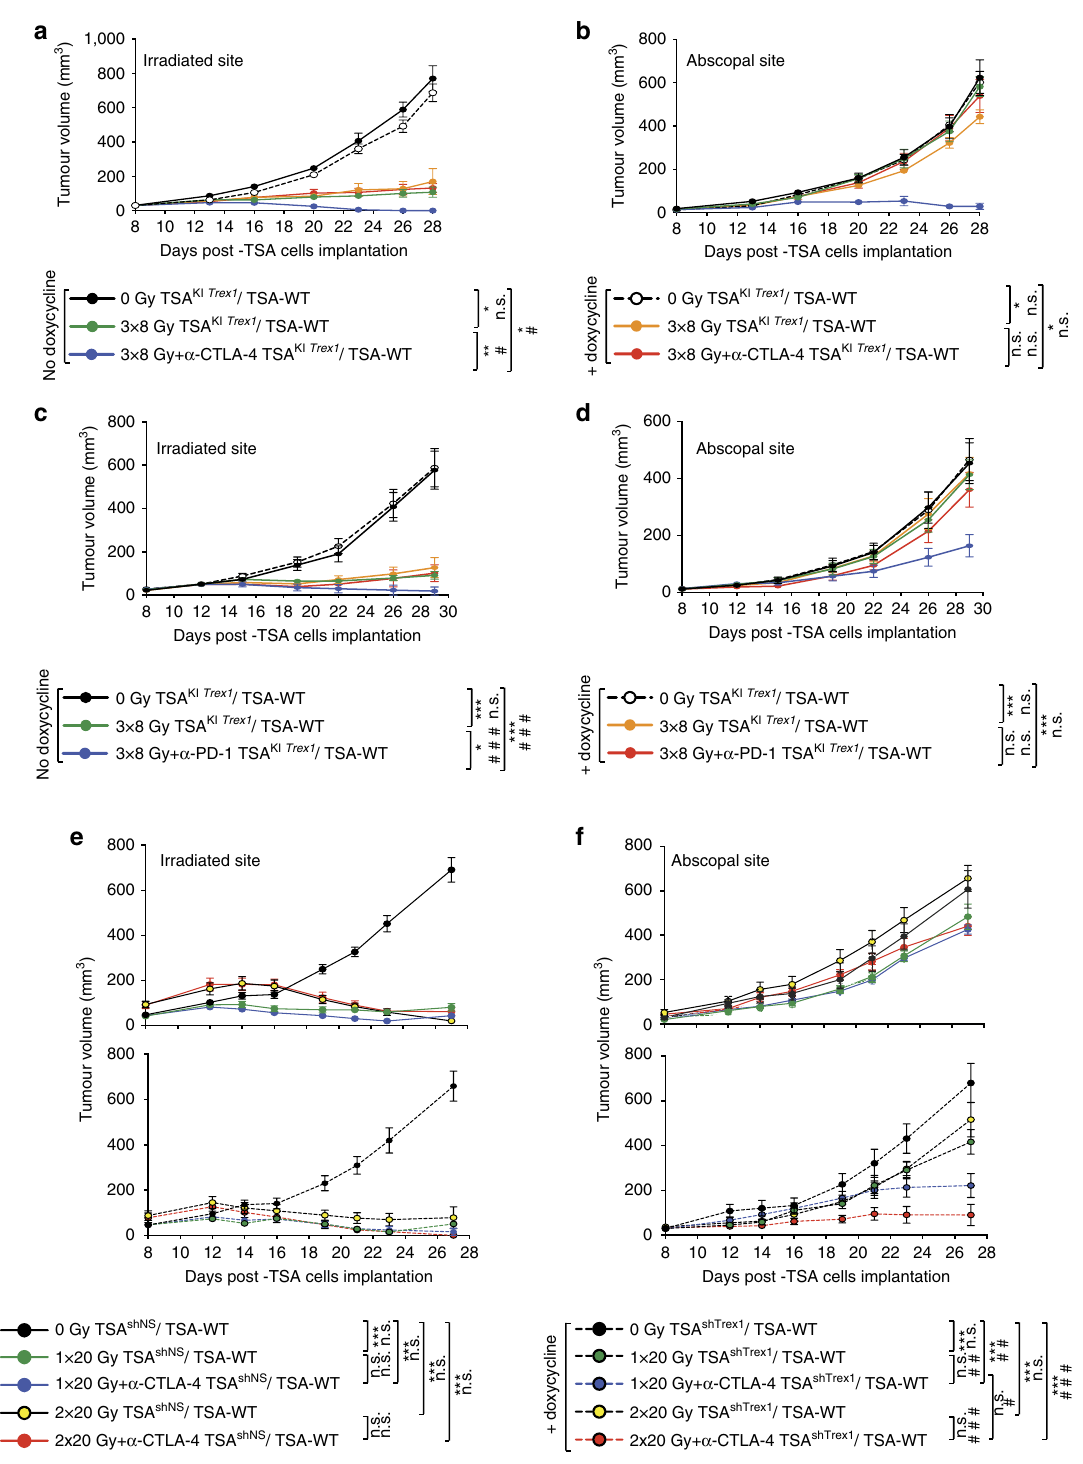
Figure 6 | Trex1 regulates radiation-induced abscopal responses in combination with immune checkpoint inhibitors. Half of the mice with doxycycline- inducible Trex1 in TSA cells (TSA KI Trex1 ) in the irradiated tumour and parental TSA (TSA-WT) in the abscopal tumour were given doxycycline and all mice were then treated with 8GyX3 and anti-CTLA4 ( a , b ) or anti-PD-1 ( c , d ). Growth of irradiated ( a ) and abscopal ( b ) tumour in mice treated with 0 Gy (black), 0 Gy þ doxycycline (dashed line), 3 (cid:3) 8 Gy (green), 3 (cid:3) 8 Gy þ doxycycline (yellow); 3 (cid:3) 8 Gy þ anti-CTLA4 (blue) and 3 (cid:3) 8 Gy þ anti- CTLA4 þ doxycycline (red). Growth of irradiated ( c ) and abscopal ( d ) tumour in mice treated with 0 Gy (black), 0 Gy þ doxycycline (dashed line), 3 (cid:3) 8 Gy (green), 3 (cid:3) 8 Gy þ doxycycline (yellow); 3 (cid:3) 8 Gy þ anti-PD-1 (blue) and 3 (cid:3) 8 Gy þ anti-PD-1 þ doxycycline (red). Mice with TSA shTrex1 (broken lines) or non-silencing shRNA (TSA shNS ) (solid lines) in the irradiated tumour and TSA shNS in the abscopal tumour were treated with doxycycline to induce Trex1 knockdown ( e , f ). Growth of irradiated ( e ) and abscopal ( f ) tumour in mice treated with 0 Gy (black), 1 (cid:3) 20 Gy (green), 1 (cid:3) 20 Gy þ anti-CTLA4 (blue), 2 (cid:3) 20 Gy (yellow), 2 (cid:3) 20 Gy þ anti-CTLA4 (red). (Duplicate; * P o 0.05; ** P o 0.005: comparison of irradiated tumour growth; two-way ANOVA; n ¼ 7; ## P o 0.005: comparison of abscopal tumour growth; two-way ANOVA; n ¼ 7). All data are mean ±